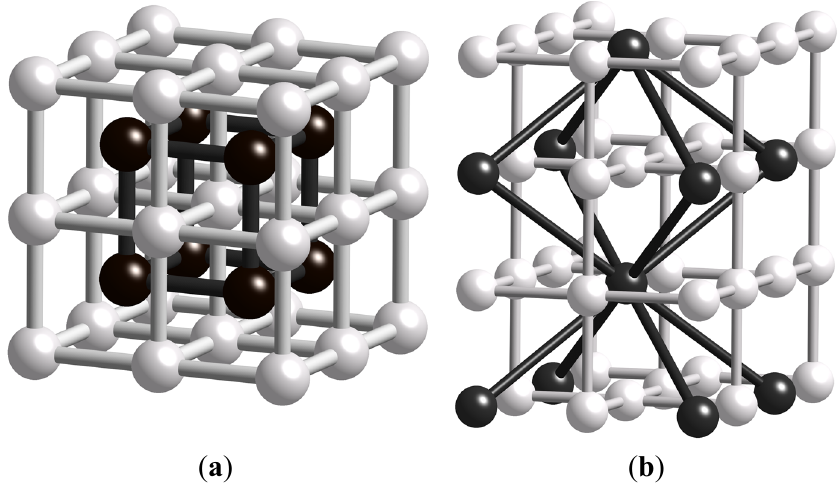
Figure 3. ( a ) The pcu net transitivity 1111 with its dual net that is an identical pcu net (self-dual); ( b ) The nbo net in white, transitivity 1111, with its dual the bcu net, also